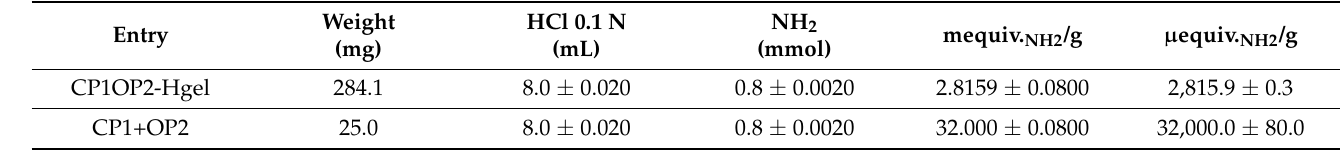
Table 5. NH 2 equivalents contained in the gel determined using the data obtained by its potentiom- etric titration.